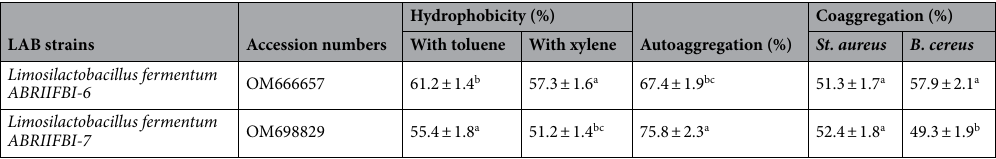
Table 3. Molecular name, accession numbers, hydrophobicity, autoaggregation, and coaggregation ability of evaluated strains. Values are mean ± standard deviation. Different lowercase superscript letters are significantly different (P ≤ 0.05). All experiments were repeated